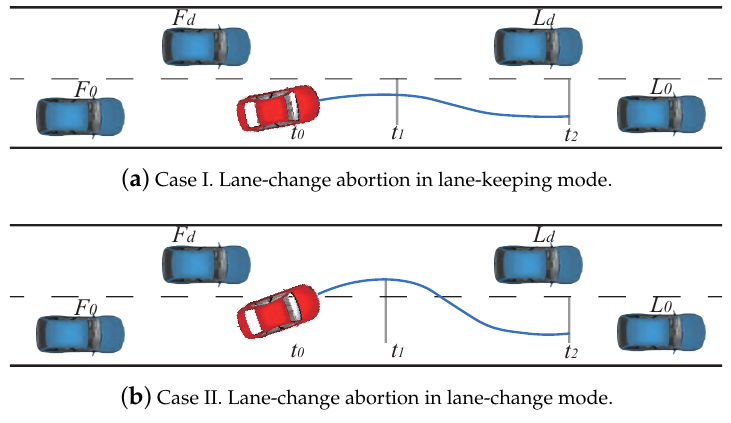
Figure 7. The phases decomposition for canceling lane change. For the second case, the lane-change abortion process is divided into three stages, namely, the adjustment period, the transition period, and the post period. In the adjustment period, the host vehicle adjusts the lateral velocity and heading angle. In the transition period, the host vehicle returns to the original lane. In the post period, the host vehicle adjusts the speed and position in the original lane. In each phase, the host vehicle follows different constraints in the longitudinal position. Similarly to the left lane-change scenario, the critical lateral position for the right lane-change can be defined as shown in Figure 8.